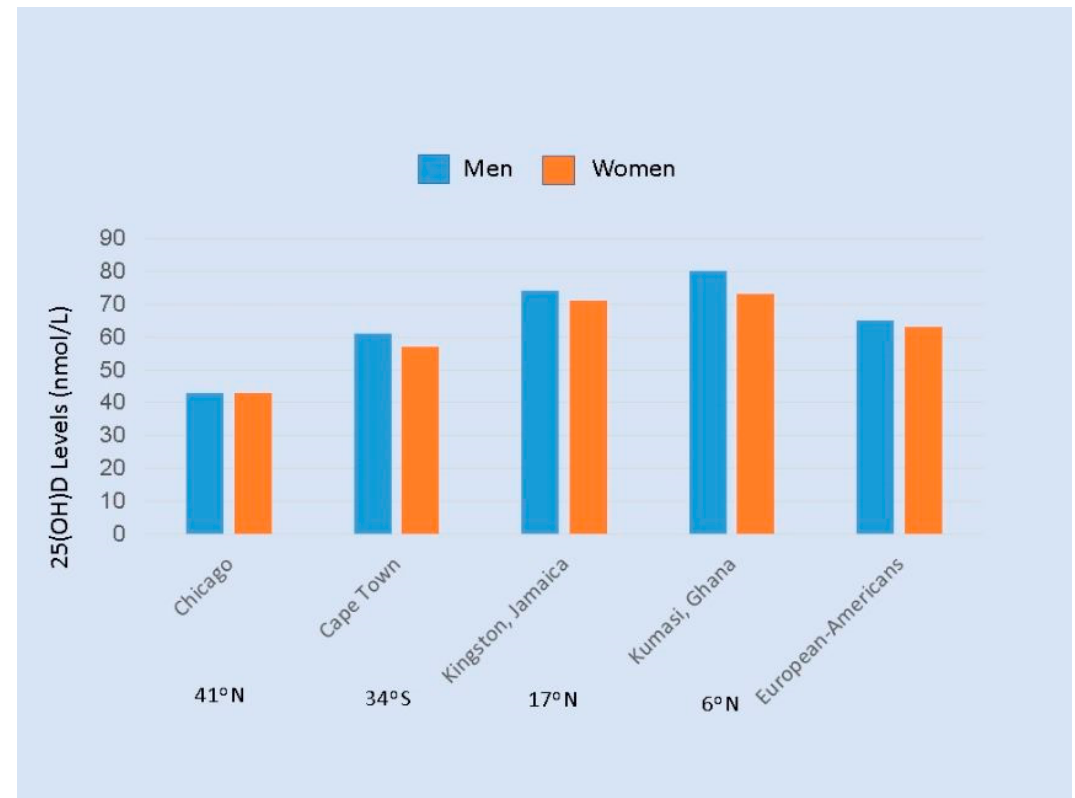
Figure 1. Average serum 25(OH)D levels (nmol/L) in men and women of African Ancestry ages 25 to 45 years living in four sites [32], and European Americans. The latitudes of the cities are given below the names of the cities. Note: Divide by 2.5 to convert nmol/L to ng/mL.